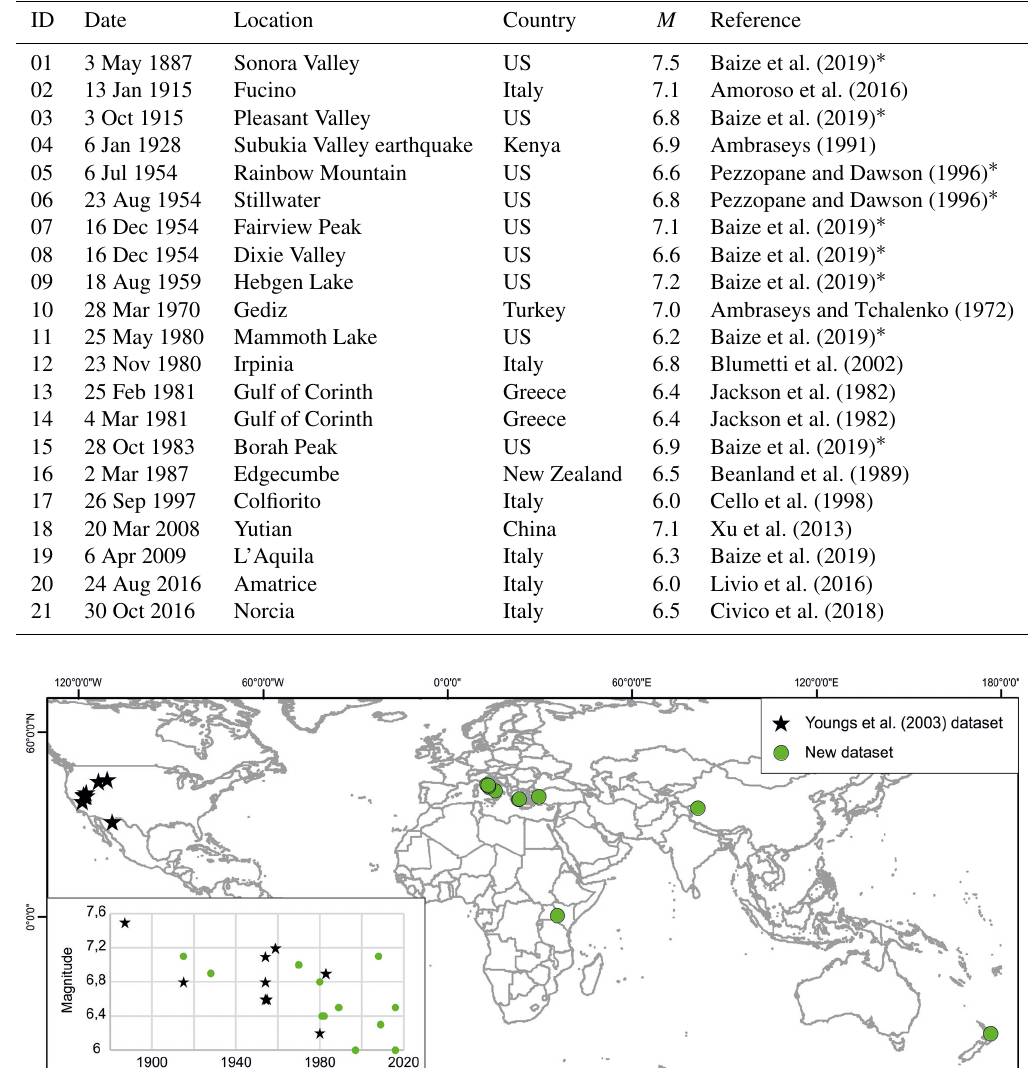
Table 1. Details on the 21 earthquakes analyzed in the present study. The references list the sources for the map of surface ruptures. “ ∗ ” in the reference column highlights the events that were included in the work by Youngs et al. (2003).